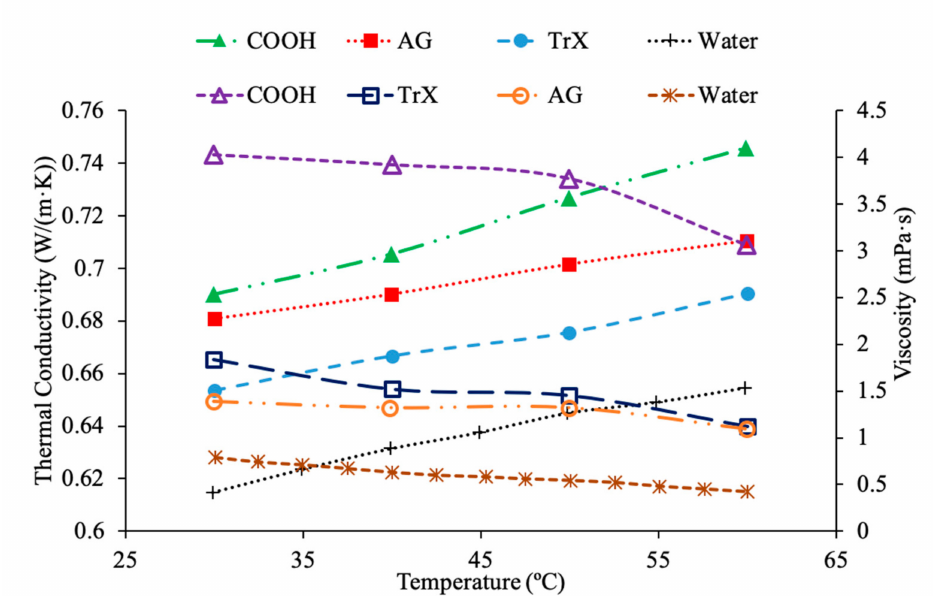
Figure 14. Thermal conductivity (increasing with temperature) and viscosity (decreasing with temperature) of multiwalled carbon nanotube (MWCNT)–water nanofluid at 1 wt %, with a COOH acid group, Triton’s X-100(TrX) at 0.25 weight percent, or Arabic Gum (AG) at 0.25 wt % surfactants shown using measurements